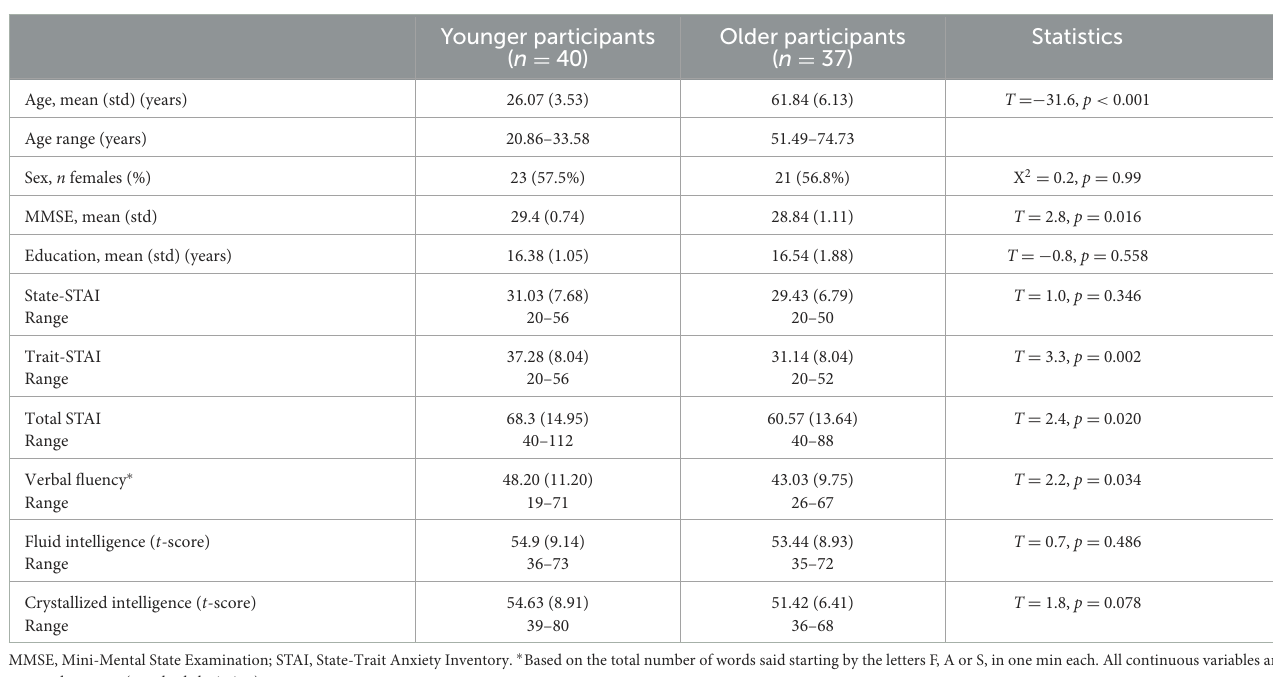
TABLE 1 Demographic information for each age group.